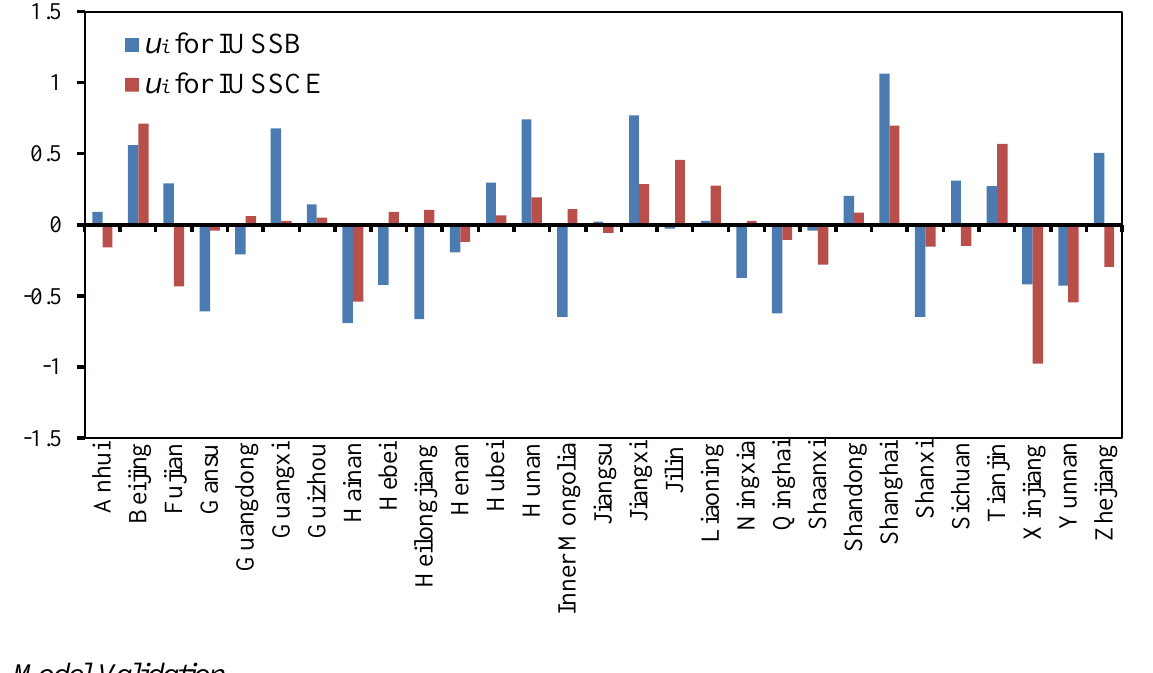
Figure 7. Random-error component u